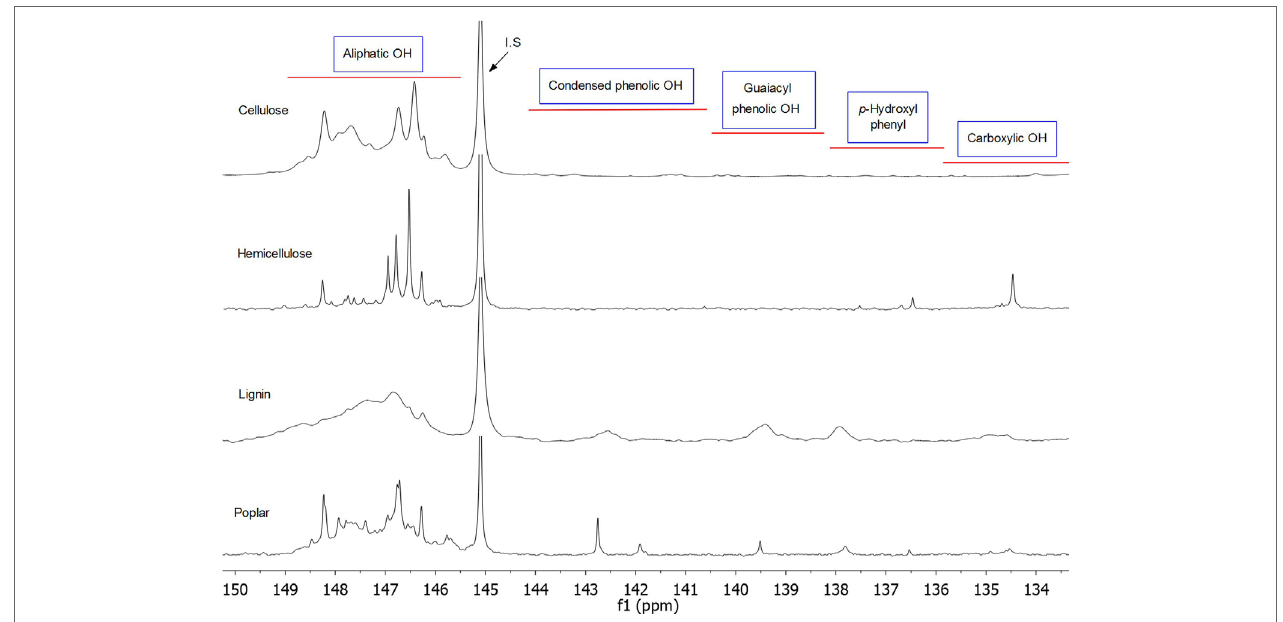
FigUre 3 | 31 P NMR spectra for cellulose, hemicellulose, lignin, and poplar whole biomass after dissolution and phosphitylation with TMDP in ionic